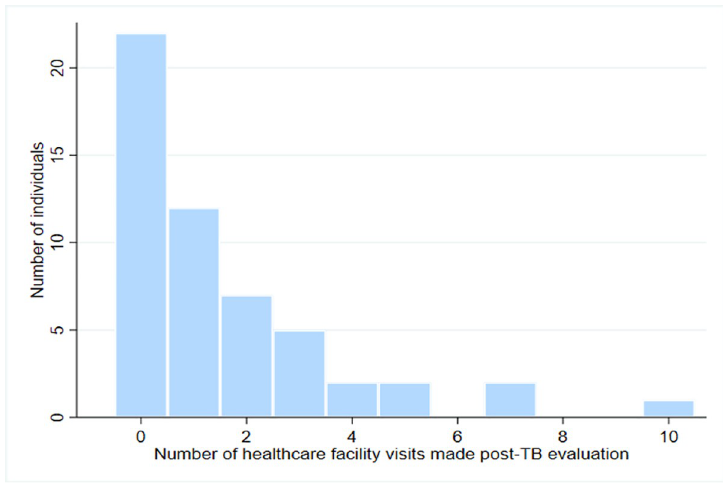
Fig 2. The distribution of healthcare facility visits made by study participants after TB